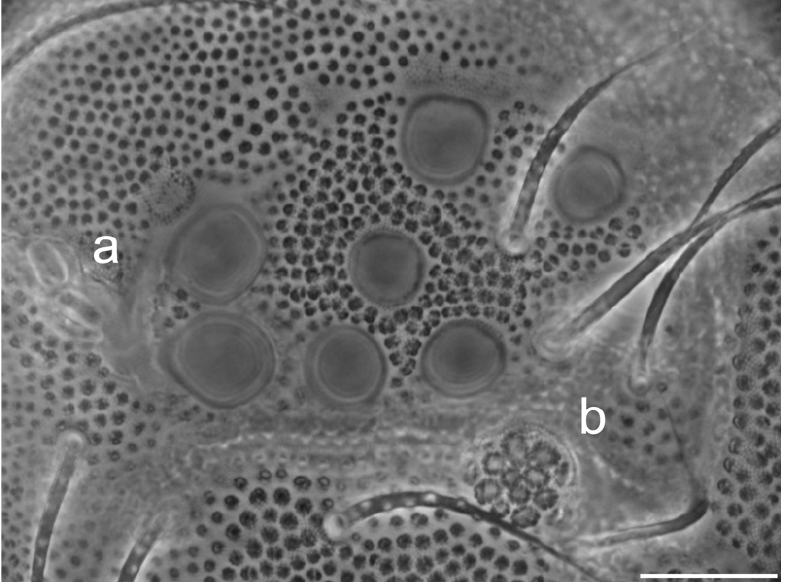
Figure 4. Ceratophysella meridionalis : ocular area, with PAO at left ( a ) and tubercle at right ( b ) (scale bar, 0.02 mm).